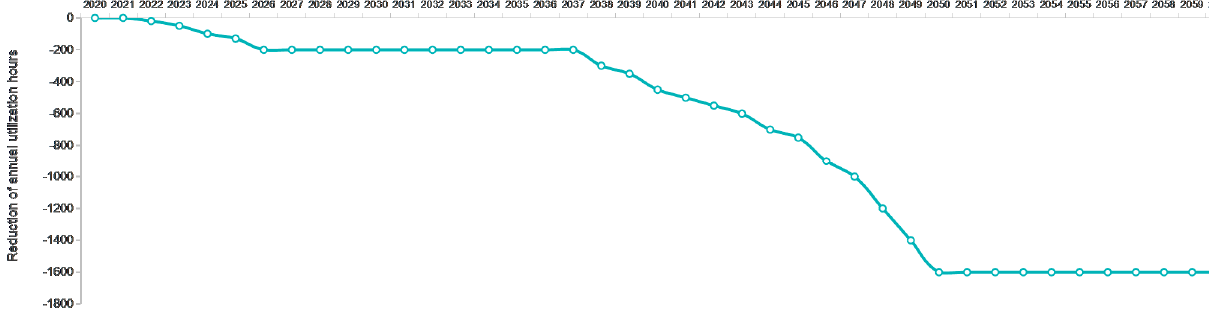
Figure 10. Forecast of the annual utilization hours reduction of coal-fired power units in China from 2020 to 2060. 2020 to